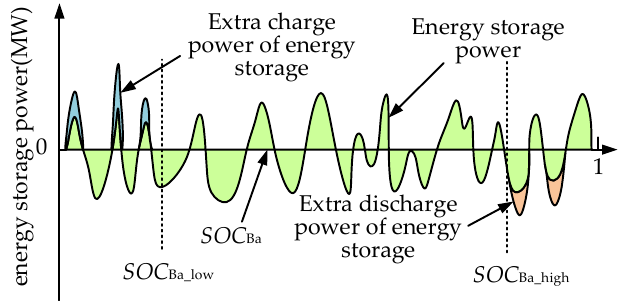
Figure 5. Changes in the HESS power command when the SOC Ba of battery is